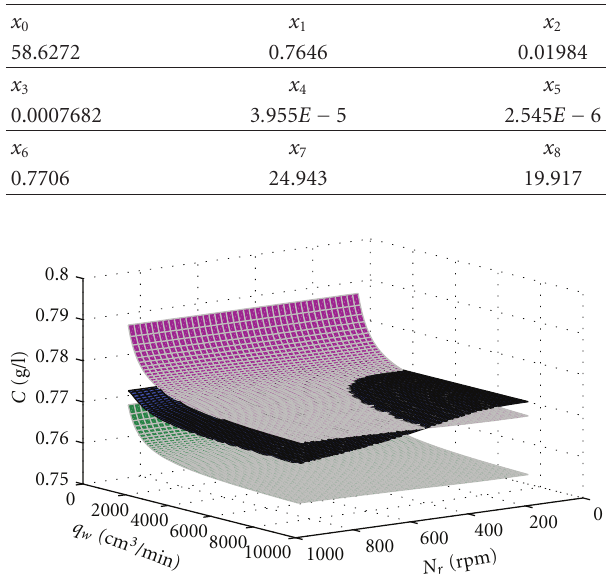
Table 2: Equilibrium state variables calculated at operation condi- tions q w = 800 cm 3 /min and N r = 420 rpm.